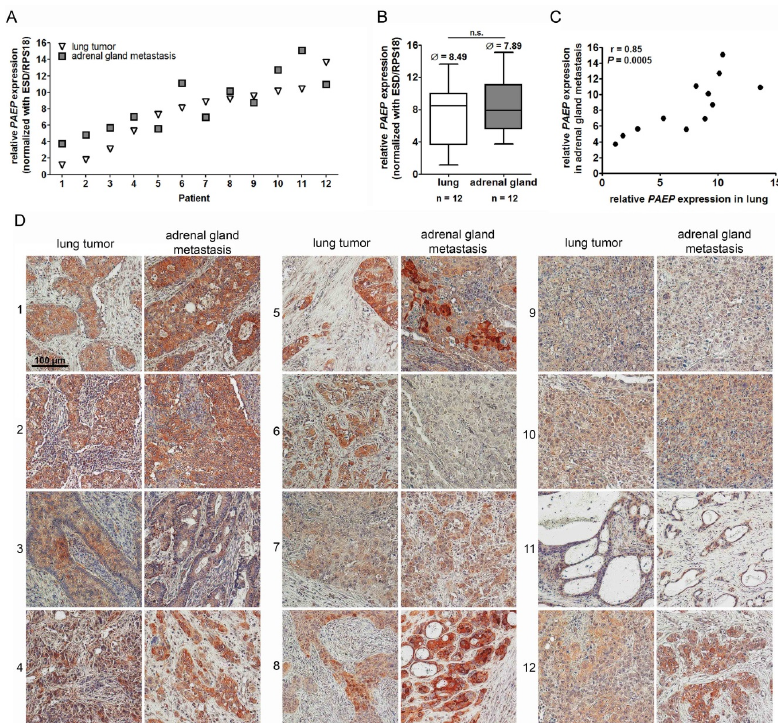
Figure 1. Glycodelin expression in primary tumors and adrenal gland metastases. 12 patient specimens (paired primary lung tumors and adrenal gland metastases) were investigated for PAEP /glycodelin expression. ( A ) Relative PAEP gene expression ( ∆ Ct) in primary tumors and adrenal gland metastases. Please note that a lower value means a higher gene expression. ( B ) Median expression levels of